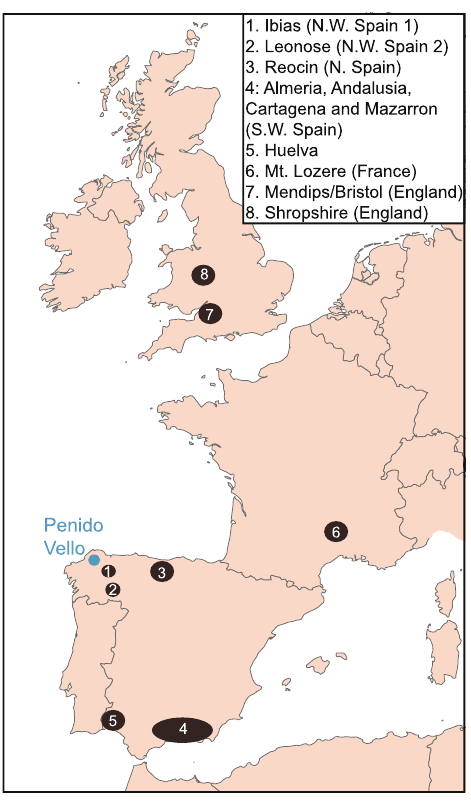
Figure 2. Map of western Europe displaying mining regions used to model contributions to Penido Vello bog (blue